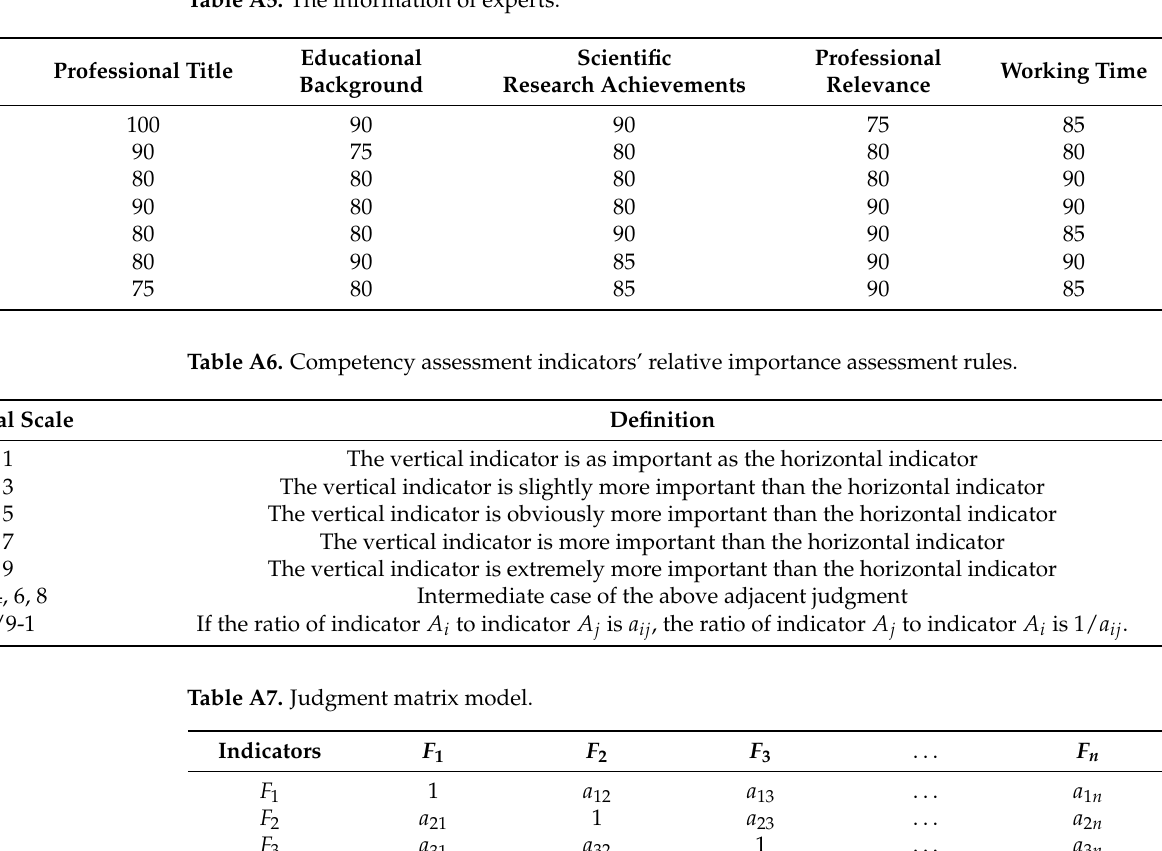
Table A5. The information of experts.